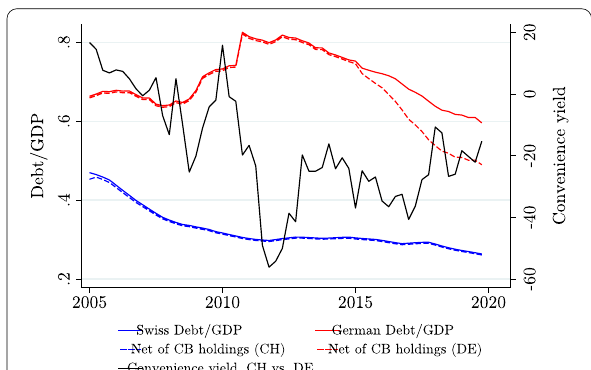
Fig. 8 The Supply of Government Bonds and the Convenience Yield. This figure represents the convenience yield of the Swiss franc versus the euro, constructed with Swiss and German bond yields at five‑year maturity Du et al. (2018), along with the Swiss and German public debts (as a percentage of GDP), from the IFS (IMF). We represent both the total debt and the total net of the domestic central bank’s holdings. The left scale corresponds to the public debt ratios, while the right scale corresponds to the convenience